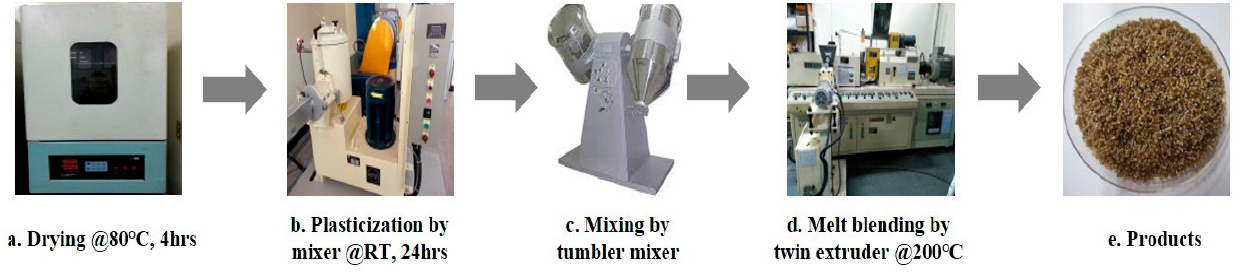
Figure 8. Process of preparing the cellulose acetate propionate–biofiller composite by melt blend- ing.